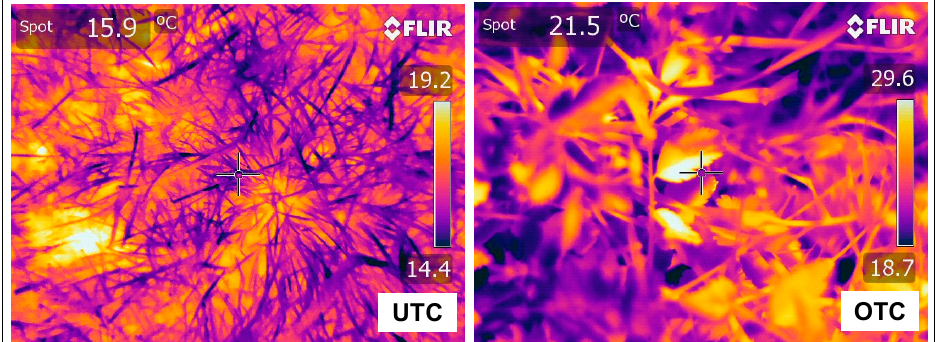
Figure 17. Thermal images obtained by infrared camera in April 2016, at two sampling points: one under tree canopy (UTC) and other outside tree canopy (OTC).